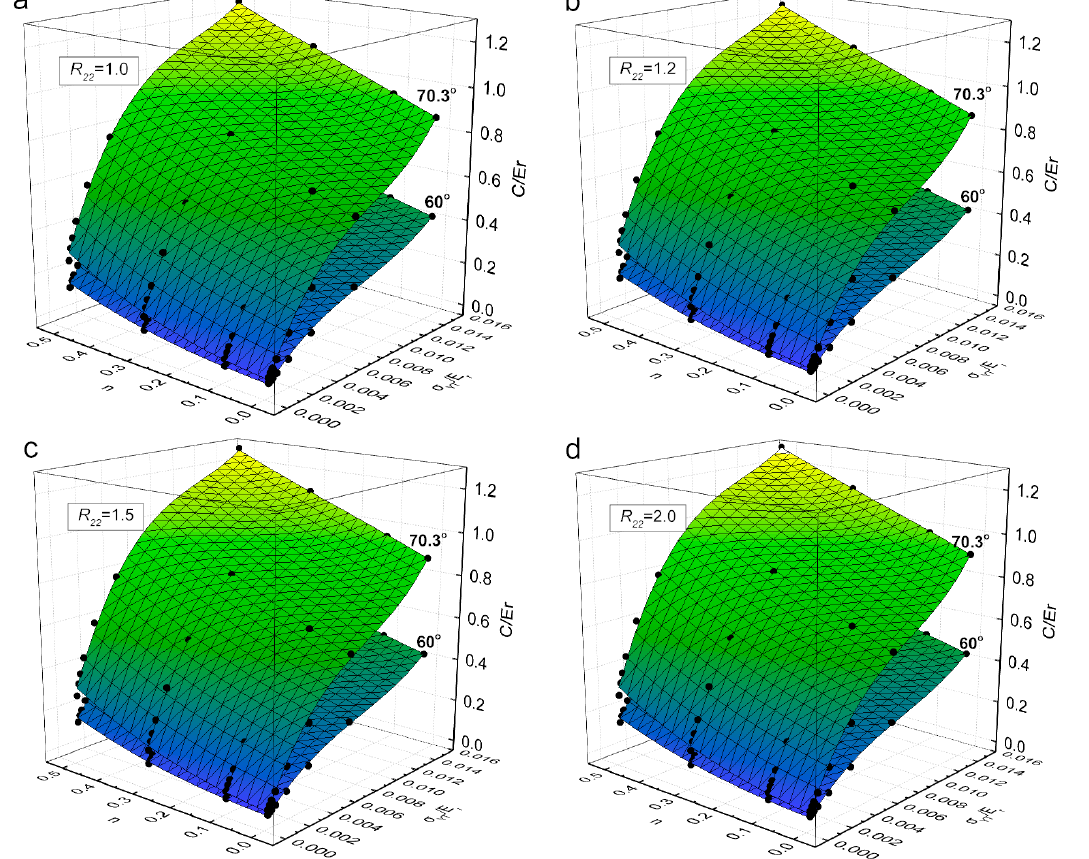
Figure 7. Representative fitting surfaces of dimensionless functions Π (cid:2869)(cid:2874)(cid:2868) and Π (cid:2870)(cid:2875)(cid:2868).(cid:2871) : ( a ) (cid:1844) (cid:2870)(cid:2870) = 1.0; ( b ) R 22 = 1.2; ( c ) R 22 = 1.5 and ( d ) R 22 =